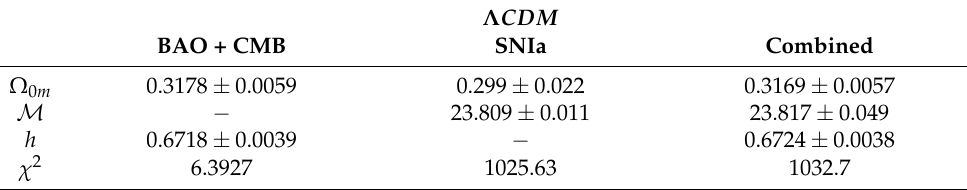
Table 2. Table containing the best-fit parameters for the Λ CDM model for different data combinations.